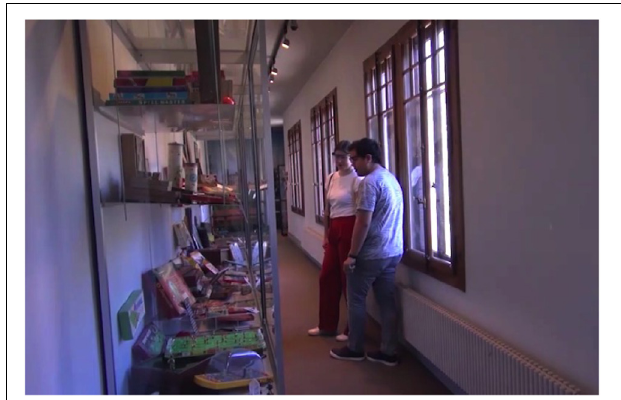
FIGURE 20 | Side-by-side configuration, facing